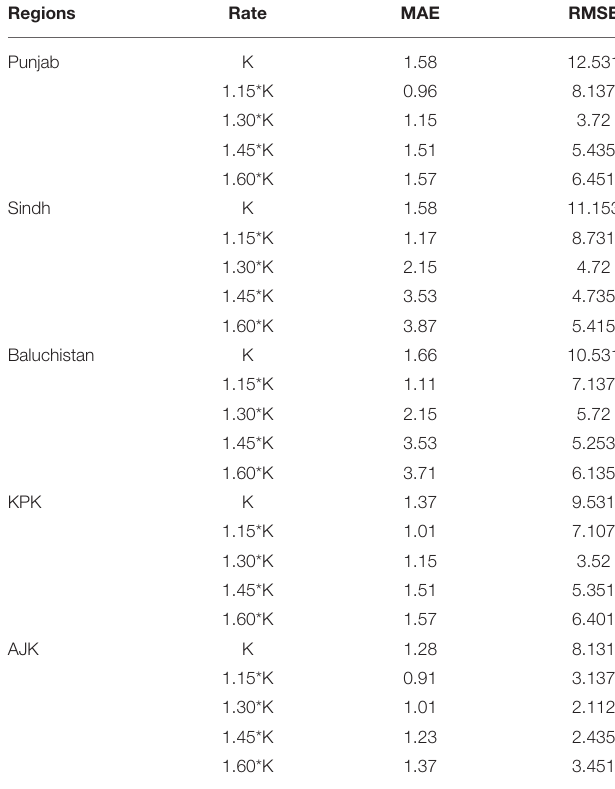
TABLE 4 | The MAE and RMAE of the hybrid models. Localities